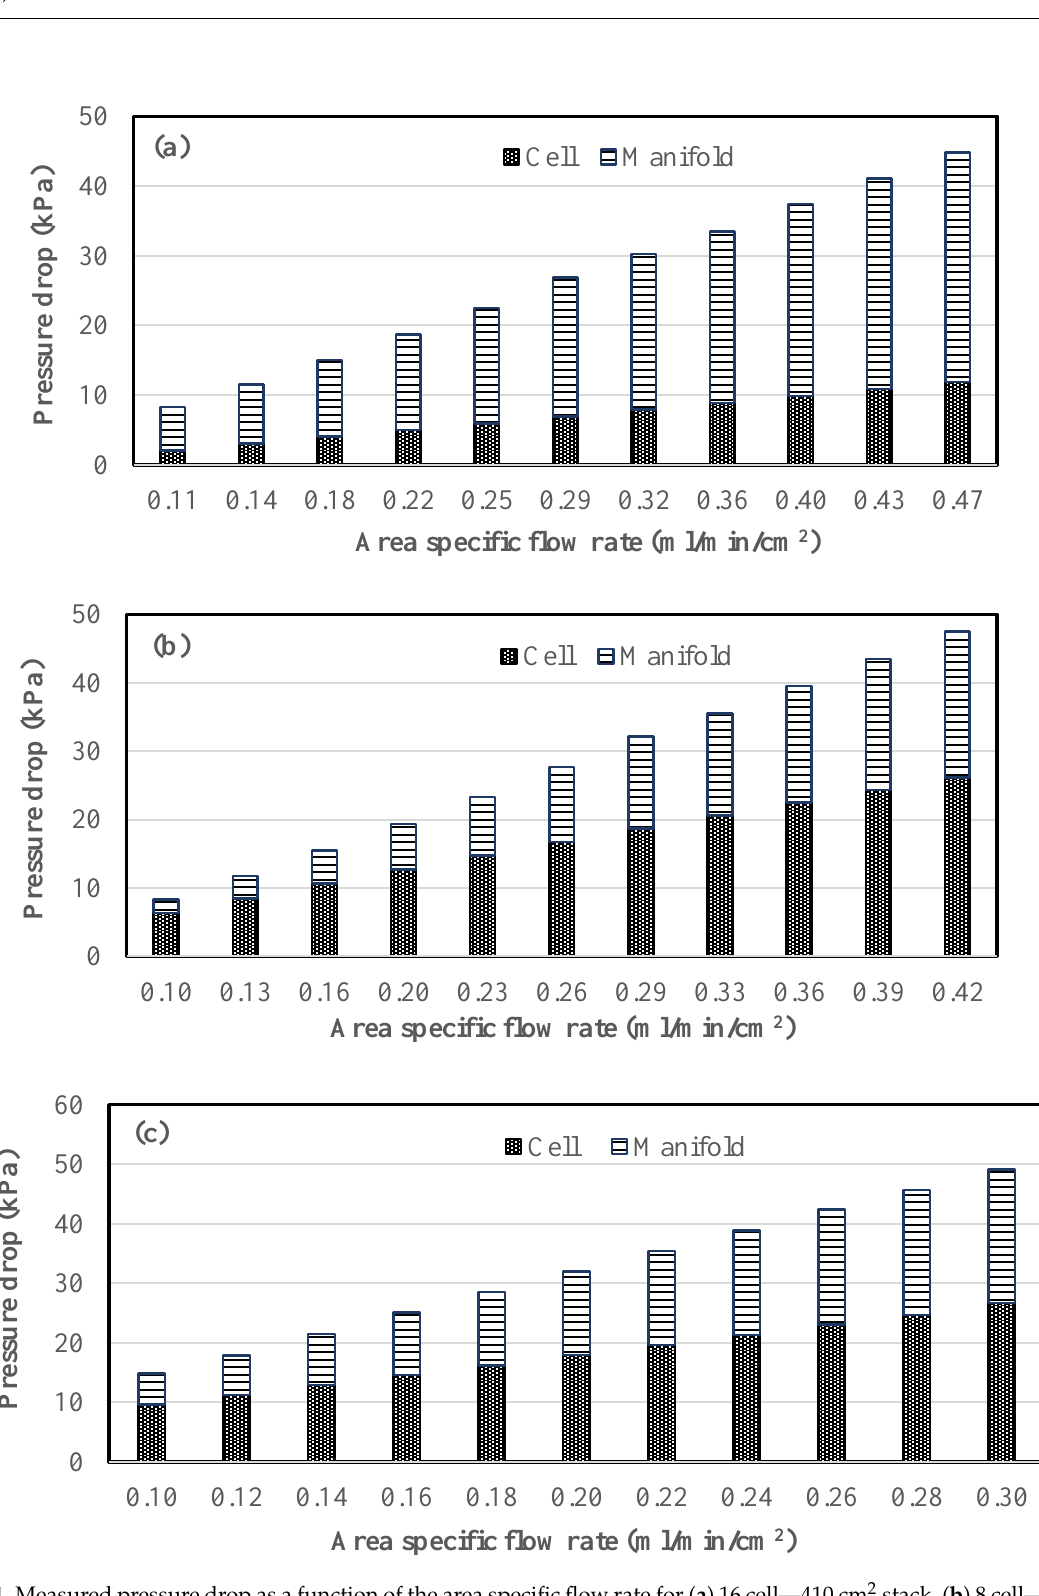
Figure 4. Measured pressure drop as a function of the area specific flow rate for ( a ) 16 cell—410 cm 2 stack, ( b ) 8 cell—918 cm 2 stack and ( c ) 8 cell—1500 cm 2 stack. The contributions of pressure drop in cell and manifolds are marked separately. Note that the flow rate range for each stack is different.